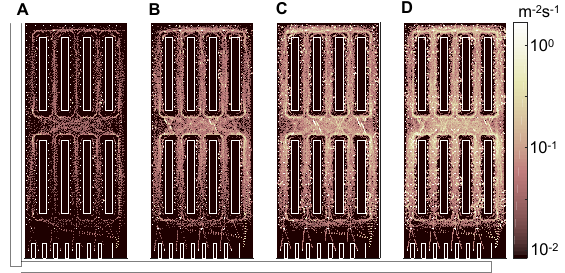
Figure 4: Density maps averaged over the 2 h simula- tion time for different occupancies. A: N = 14, B: N = 35, C: N = 62, D: N =